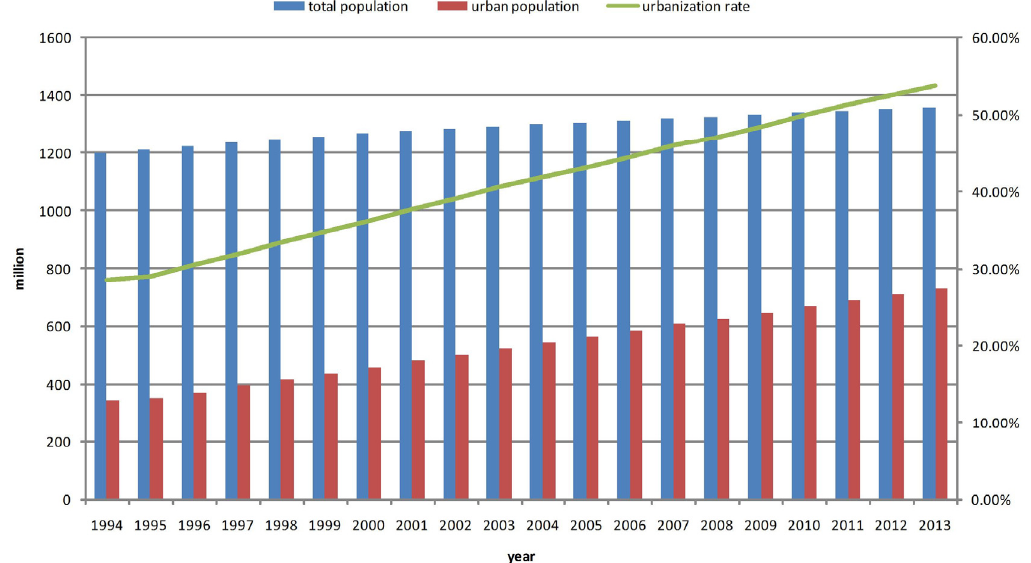
Figure 1. The urbanization trend of China over the past two decades [24].